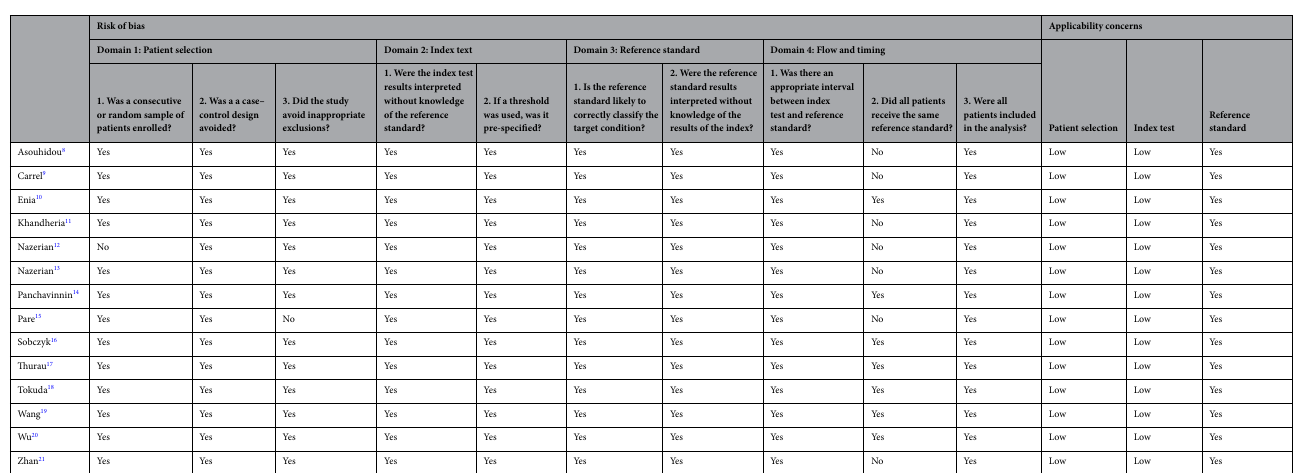
Table 2. Risk of bias assessment performed with the Quality of Assessment of Diagnostic Accuracy Studies-2 (QUADAS-2)